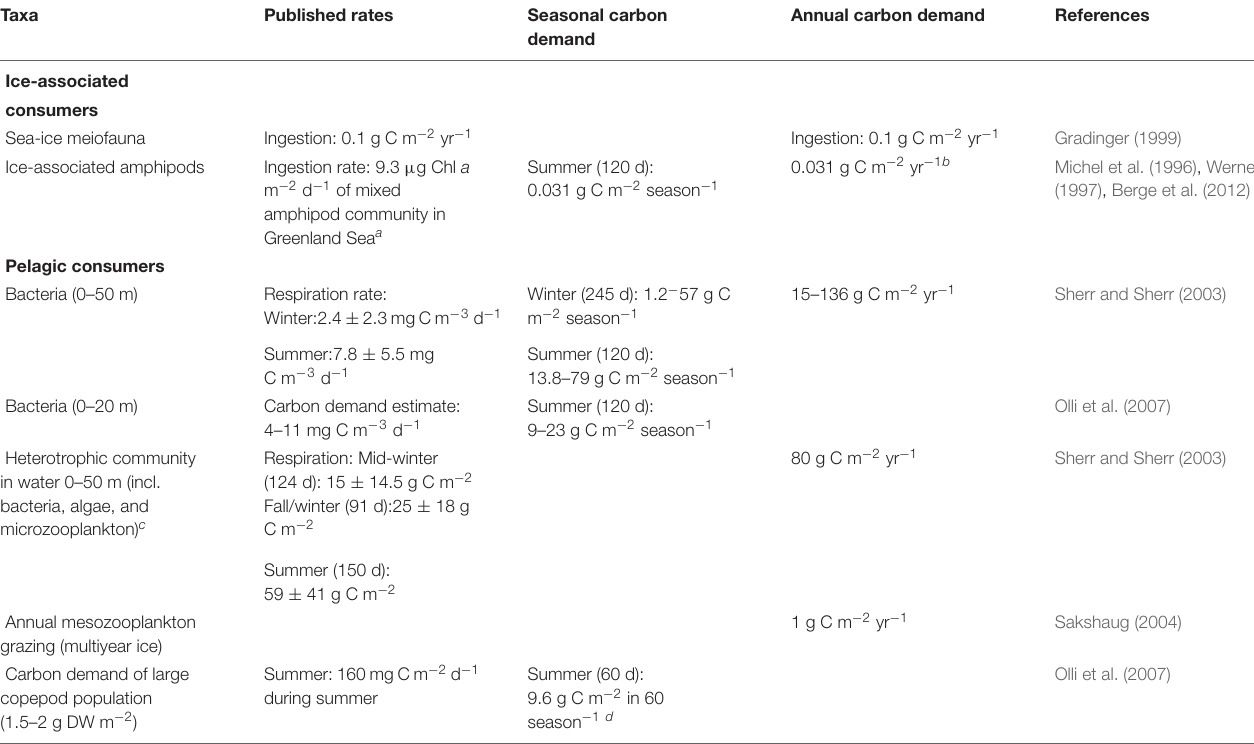
TABLE 3 | Compilation of ice-associated and pelagic consumers’ carbon